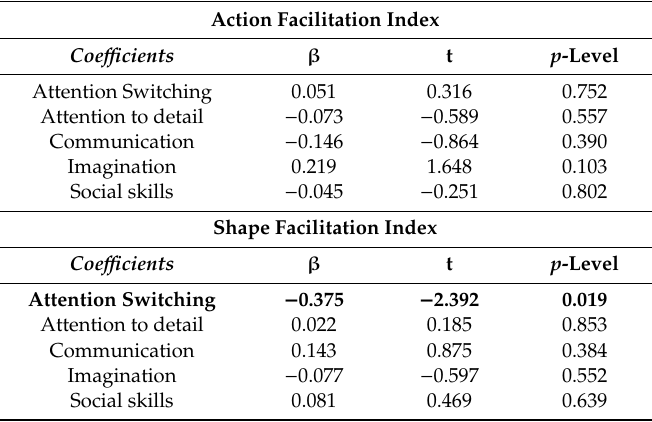
Table 2. p -Values are marked as bold, for p < 0.05.